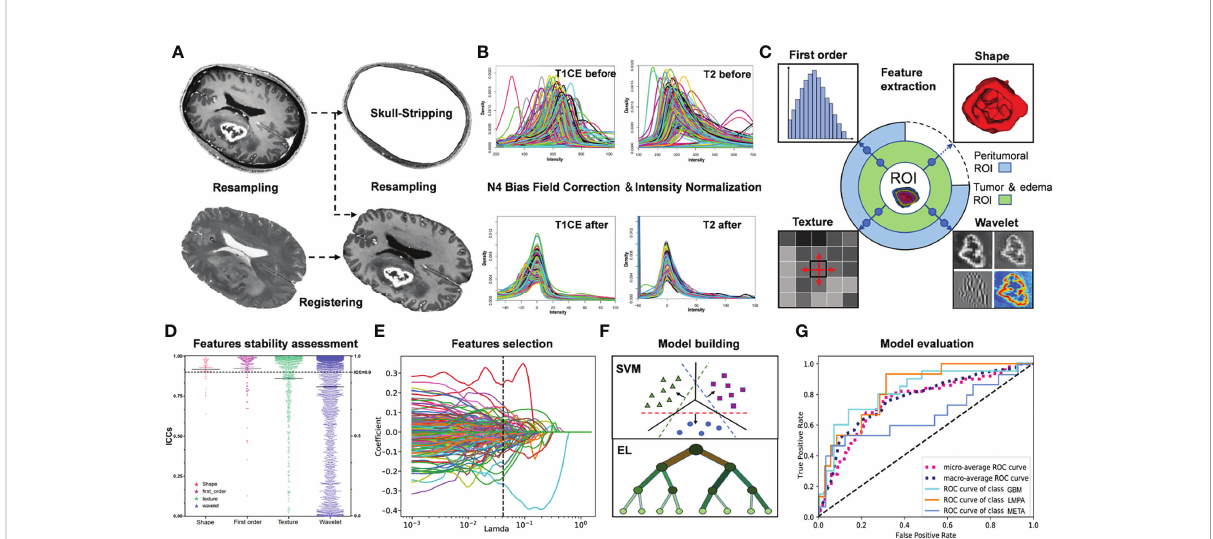
FIGURE 3 Flow chart describing the present radiomics study. (A) Image preprocessing, including skull stripping, resampling, and registration. (B) Bias fi eld correction and intensity normalization. (C) Based on the quantitative regions of interest, radiomic features were extracted, including shape, fi rst order, textural, and wavelet features from T1CE and T2 images separately. (D) Radiomic feature assessment. (E) Feature selection using different methods, such as lasso regression or random forest. (F, G) Modeling and evaluation using different classi fi ers, including support vector machine and several ensemble learning